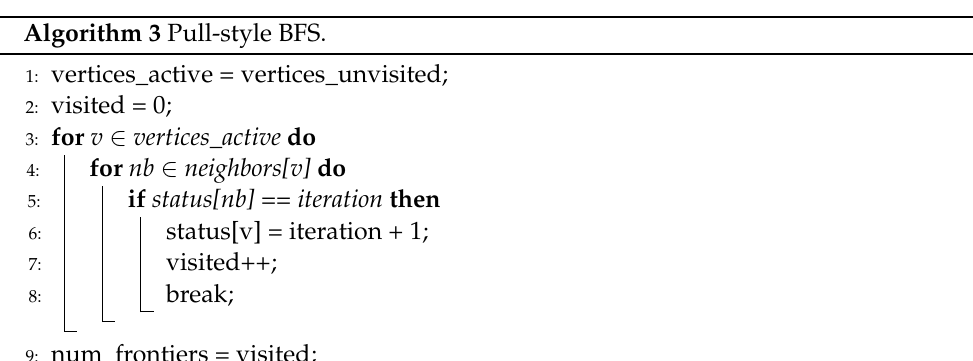
Algorithm 3 Pull-style